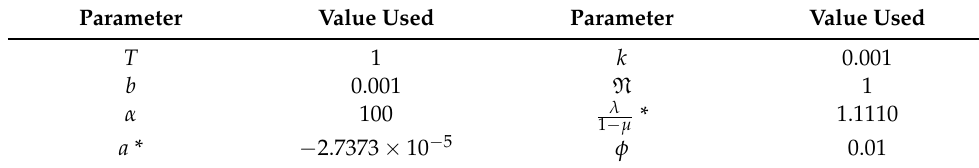
Table 3. Liquidation parameters for Amazon stock.